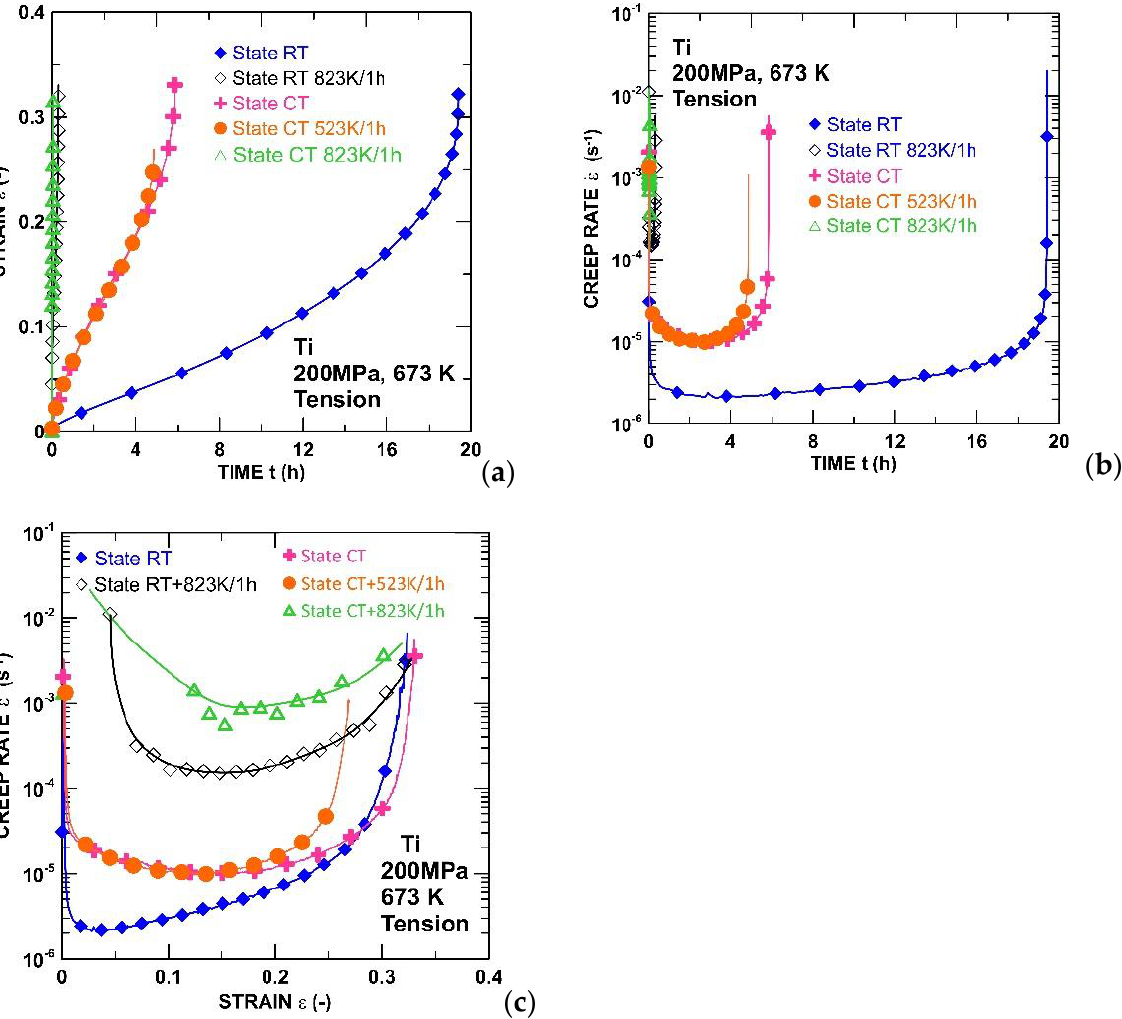
Figure 2. Creep dependence of ( a ) strain or ( b ) creep rate on time and ( c ) creep rate on strain for CP Ti processed by rolling methods.